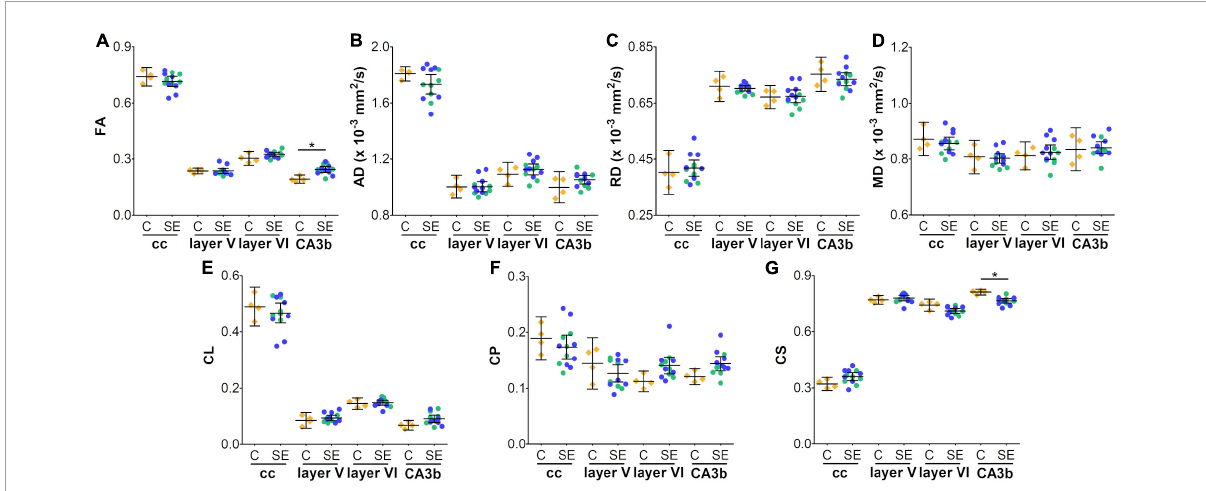
FIGURE2 In vivo DTI parameters in control and status epilepticus animals at 79 days (A–G) . Controls are represented as yellow diamonds, kainic acid-treated as green, and pilocarpine-treated as blue circles, respectively. The bars represent mean values with 95% CI. Differences between C and SE animals are denoted with asterisks (BH-FDR-corrected q -value * < 0.05; two-sided permutation t -test). SE animals exhibited an increase in FA (A) or a decrease in CS (G) parameters in the subfield CA3b as compared to controls. AD, axial diffusivity; C, control; CA, cornus ammonis; cc, corpus callosum; CL, linear anisotropy; CP, planar anisotropy; CS, spherical anisotropy; FA, fractional anisotropy; MD, mean diffusivity; RD, radial diffusivity; SE, status